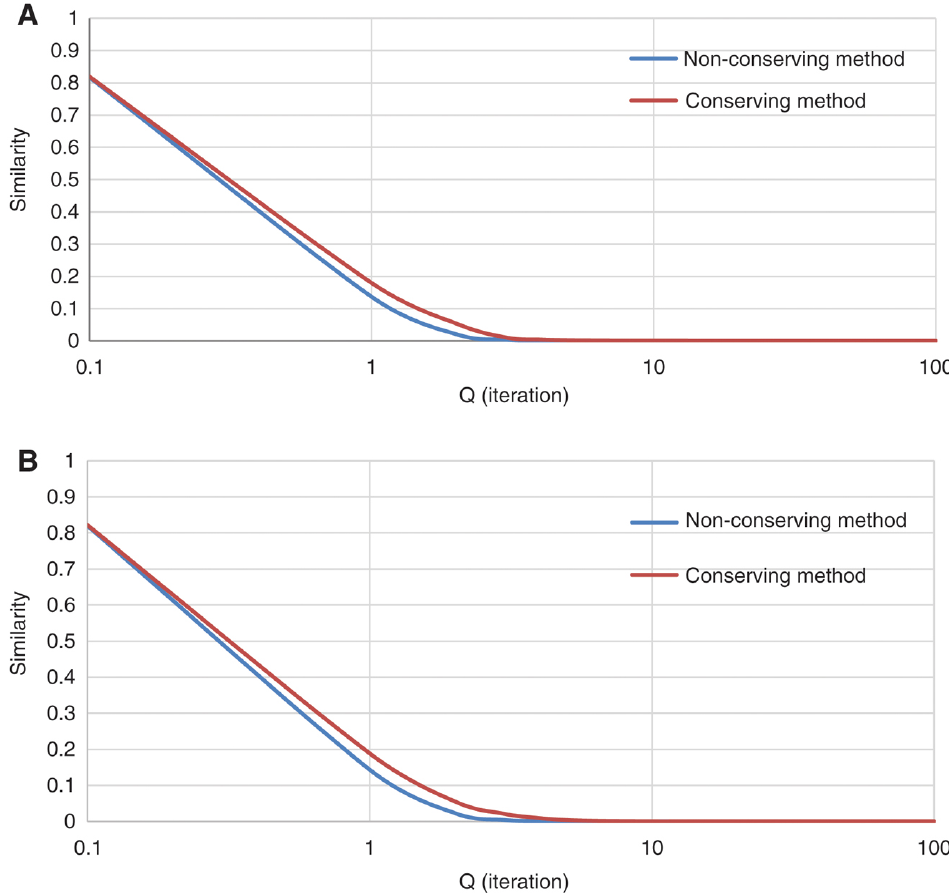
Figure 3: Similarity metric vs. number of iterations for (A) the BC-complete and (B) the GBM networks.